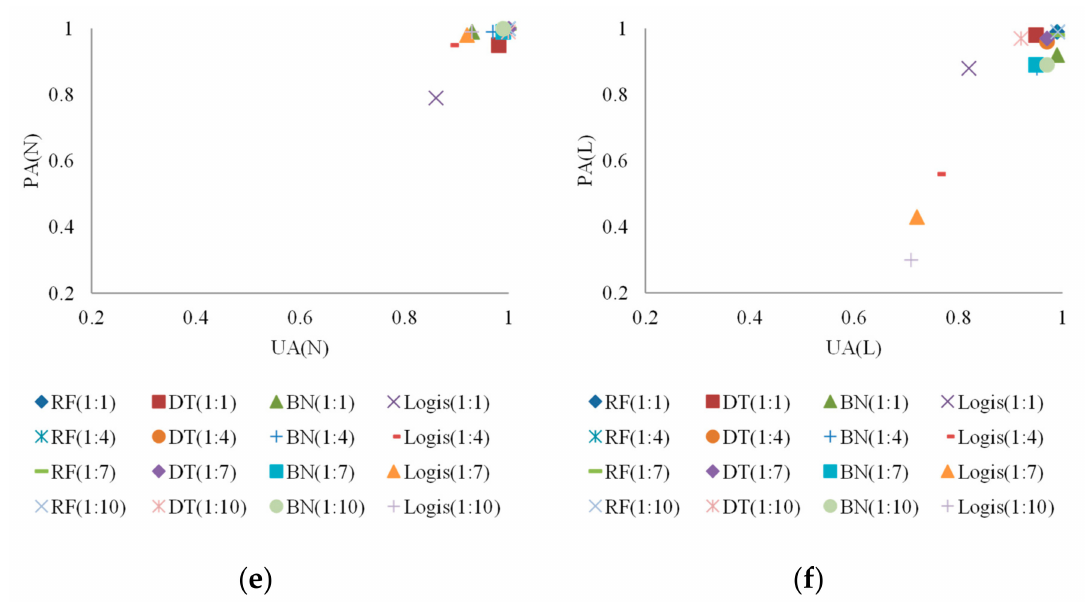
Figure 11. Space-robustness accuracies ( Y axis) of event-based landslide susceptibility assessments, considering di ff erent algorithms and proportions of landslide and non-landslide classes, where RF, DT, BN, and logistic indicate random forests, decision tree, Bayes network algorithm, and logistic algorithm, respectively. ( a ) Non-landslide detections for Typhoon Aere; ( b ) Landslide detections for Typhoon Aere; ( c ) Non-landslide detections for Typhoon Matsa; ( d ) Landslide detections for Typhoon Matsa; ( e ) Non-landslide detections for Typhoon Sinlaku; ( f ) Landslide detections for Typhoon Sinlaku.